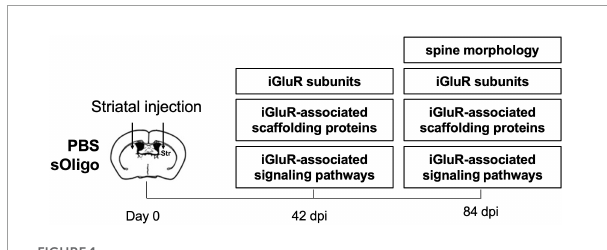
FIGURE1 Schematic representation of the experimental procedures.